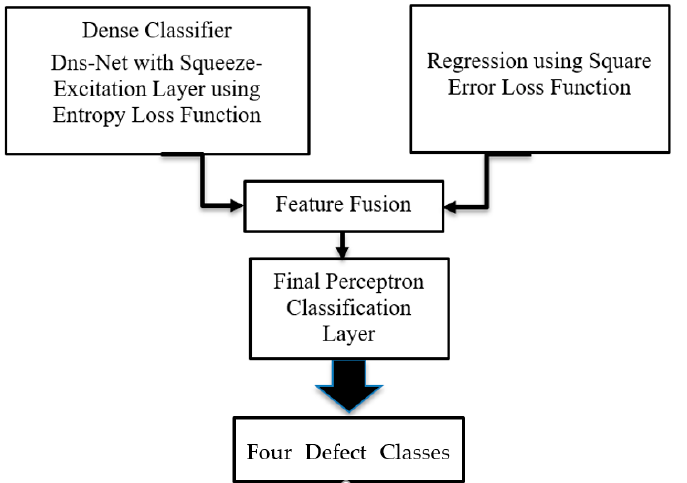
Figure 3. The Multitasking connected network with feature fusion from the squeeze model and the regression model where the classifier can predict the four classes for the input crystals.